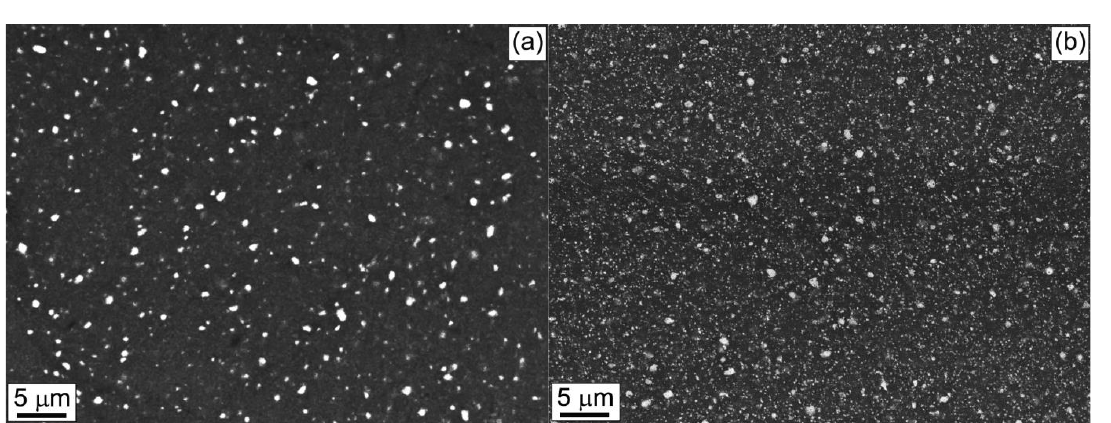
Figure 6. SEM images of hot-pressed composites with additions of ( a ) 2% stearic acid and ( b ) 5% Cu.